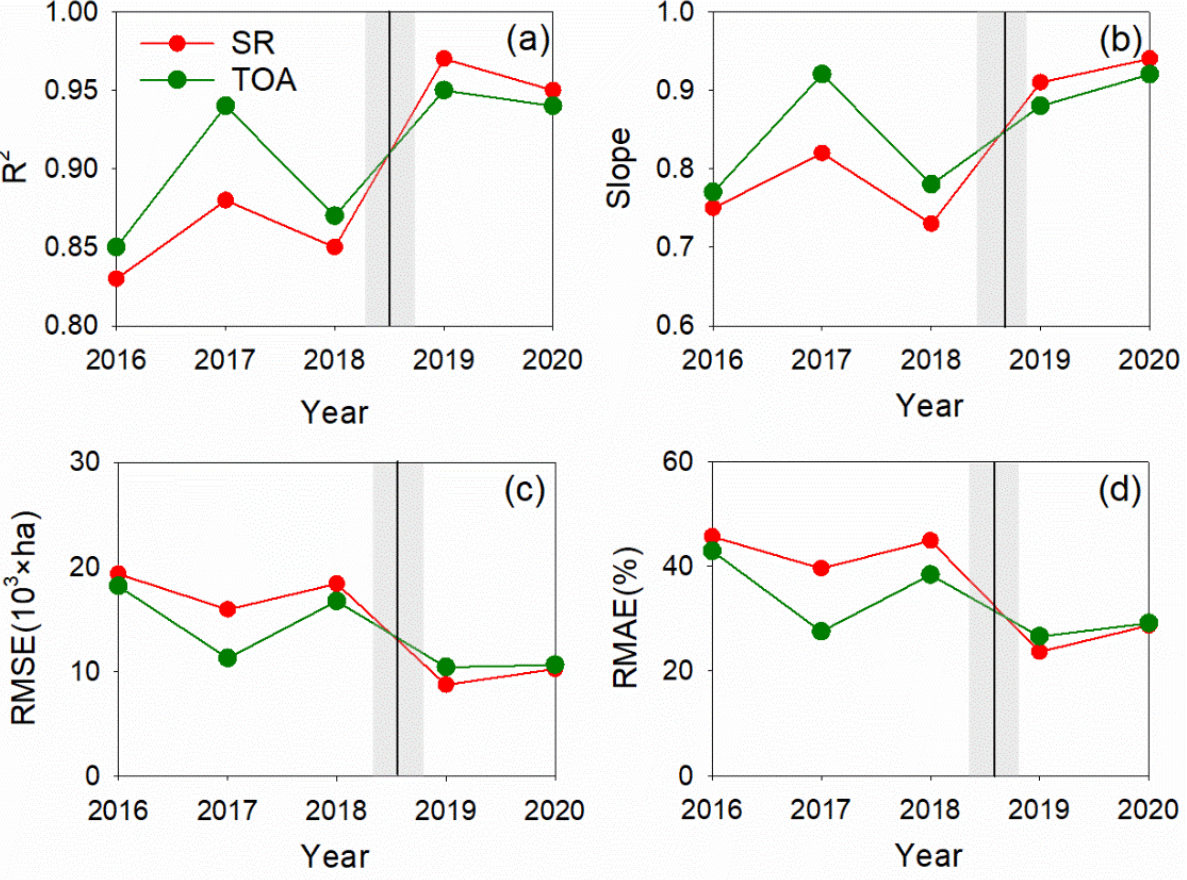
Figure 11. Comparisons of the regional performance (R 2 , slope, RMSE, and RMAE) of the method in identification sugarcane planted areas with SR and TOA data at the municipal level for China from 2016 to 2020.